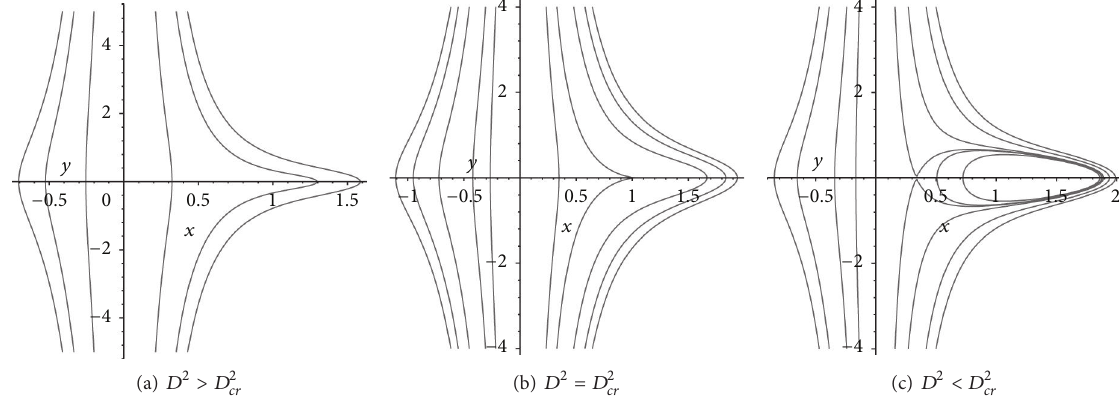
Figure 6: The phase portraits of system (6) for 𝑛 = 2𝑚 + 1 , 𝛽 > 0 , 𝐺 1 > 0 , and 𝜎 > 0